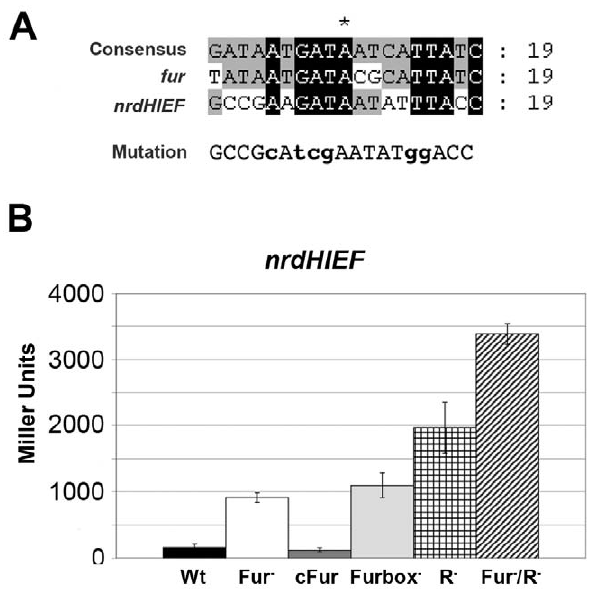
Figure 5. Fur binding sites. A. Fur box mutated sequence for the nrdHIEF promoter region. Multiple alignment with ClustalW of the E. coli Fur box consensus sequence, S. Typhimurium LT2 Fur box within the fur promoter region and S. Typhimurium LT2 Fur box in the nrdHIEF promoter region. All sequences were obtained from the NCBI database (http://www.ncbi.nml.nih.gov/). Conserved bases in all three sequences are shown in black, while bases conserved in two out of the three sequences are shown in grey. Base changes in the Fur box sequence are shown in bold lower case. B. b -galactosidase activities of the nrdHIEF - lacZ fusion expressed in Miller Units (MU) for the wild-type strain (Wt), mutant D fur strain (Fur 2 ), fur -complemented mutant strain (cFur), Fur box mutant strain (Furbox 2 ), D nrdR mutant strain (R 2 ) and D fur D nrdR double mutant strain (Fur 2 /R 2 ). Results are the mean values of duplicates of at least three independent experiments. Error bars represent the standard deviation of experiments.